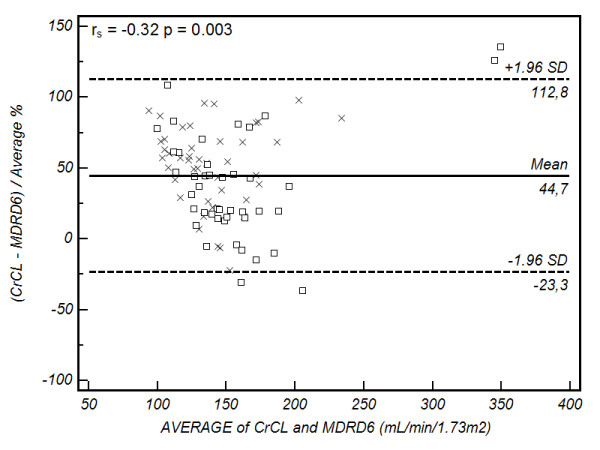
Bland-Altman plot of CLCR vs 6-variable modification of diet in renal disease equation. Comparison of the difference between the measured creatinine clearance (CLCR) and 6-variable modification of diet in renal disease equation (MDRD_6) (as a percentage) on the y-axis, versus the average value obtained on the x-axis. The solid line represents the bias (mean percentage difference obtained across the range of values), where as the dashed lines are the limits of agreement (+/- 1.96 × standard deviation (SD)). square, Australia cohort; cross, Portugal cohort. The Spearman correlation coefficient (rs) for the percentage difference and average value is provided in the top left hand corner (outliers excluded).